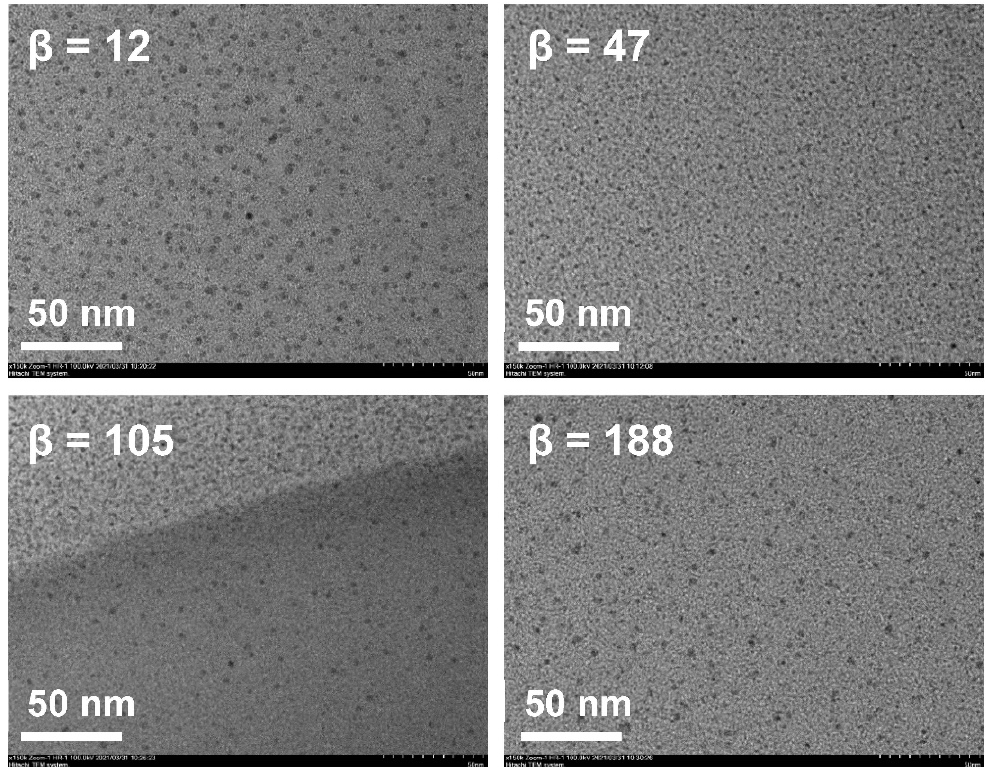
Figure 5. TEM of nanoemulsions prepared by RPB with different β .